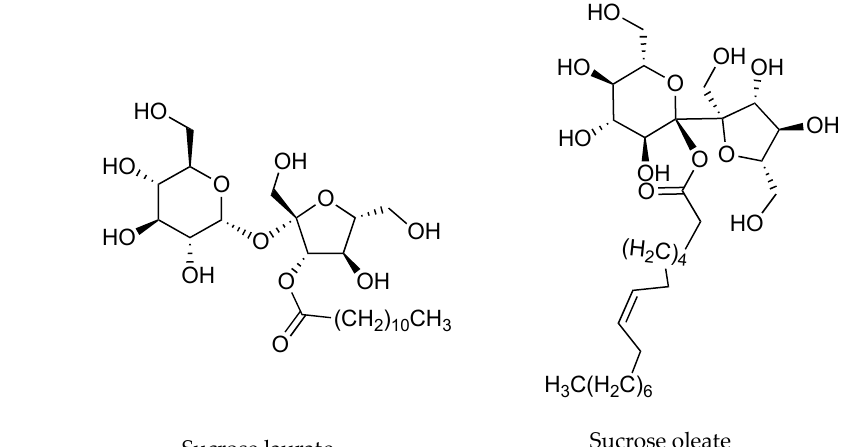
Figure 13. Lidocaine HCl with sucrose laurate and sucrose oleate.